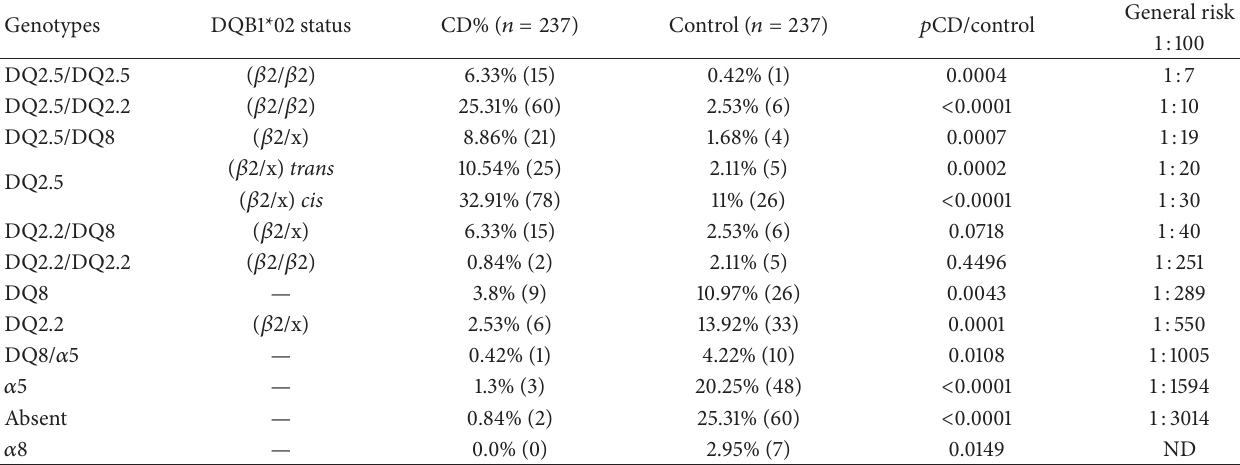
Table 1: CD predisposing HLA-DQ frequencies in CD patients and controls and general genetic risk.